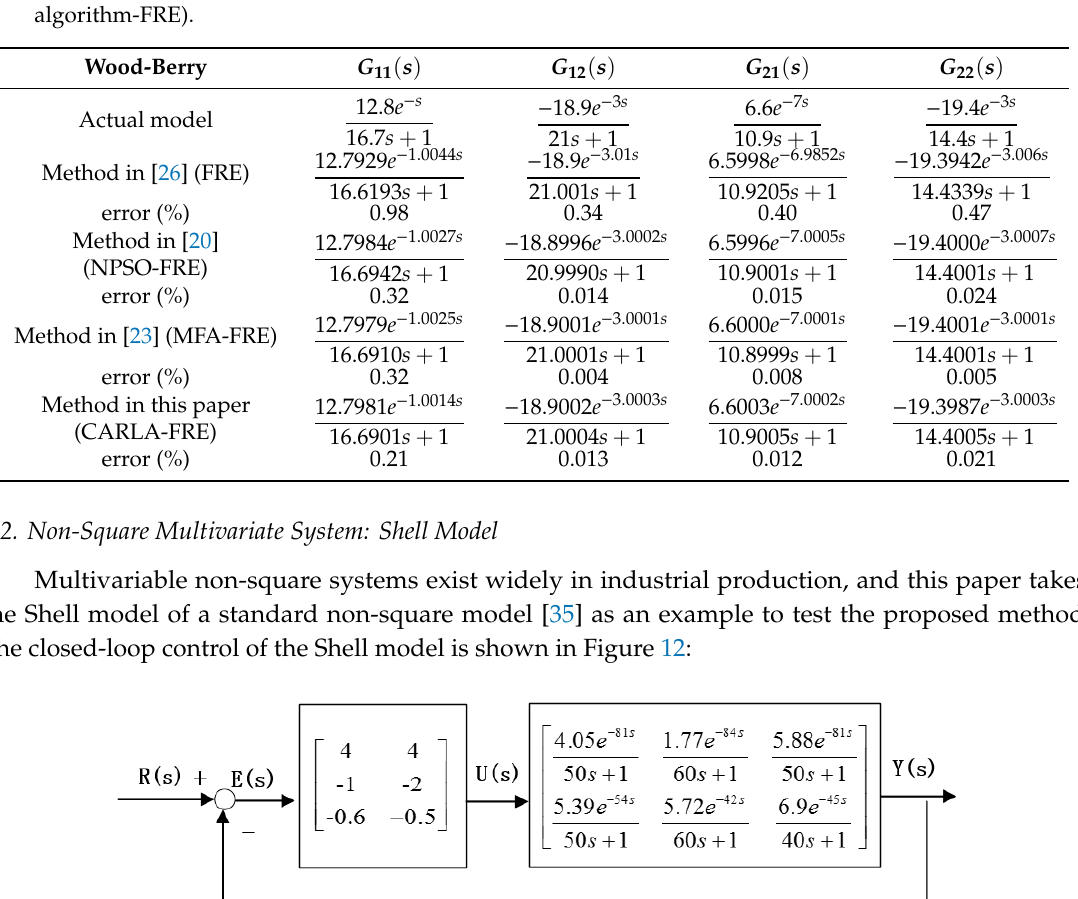
17 of 20 Table 3. Wood-Berry model identification results. (FRE: frequency response estimation; NPSO-FRE: NLG-particle swarm optimization-FRE; MFA-FRE: modified fireworks explosion optimization algorithm-FRE).